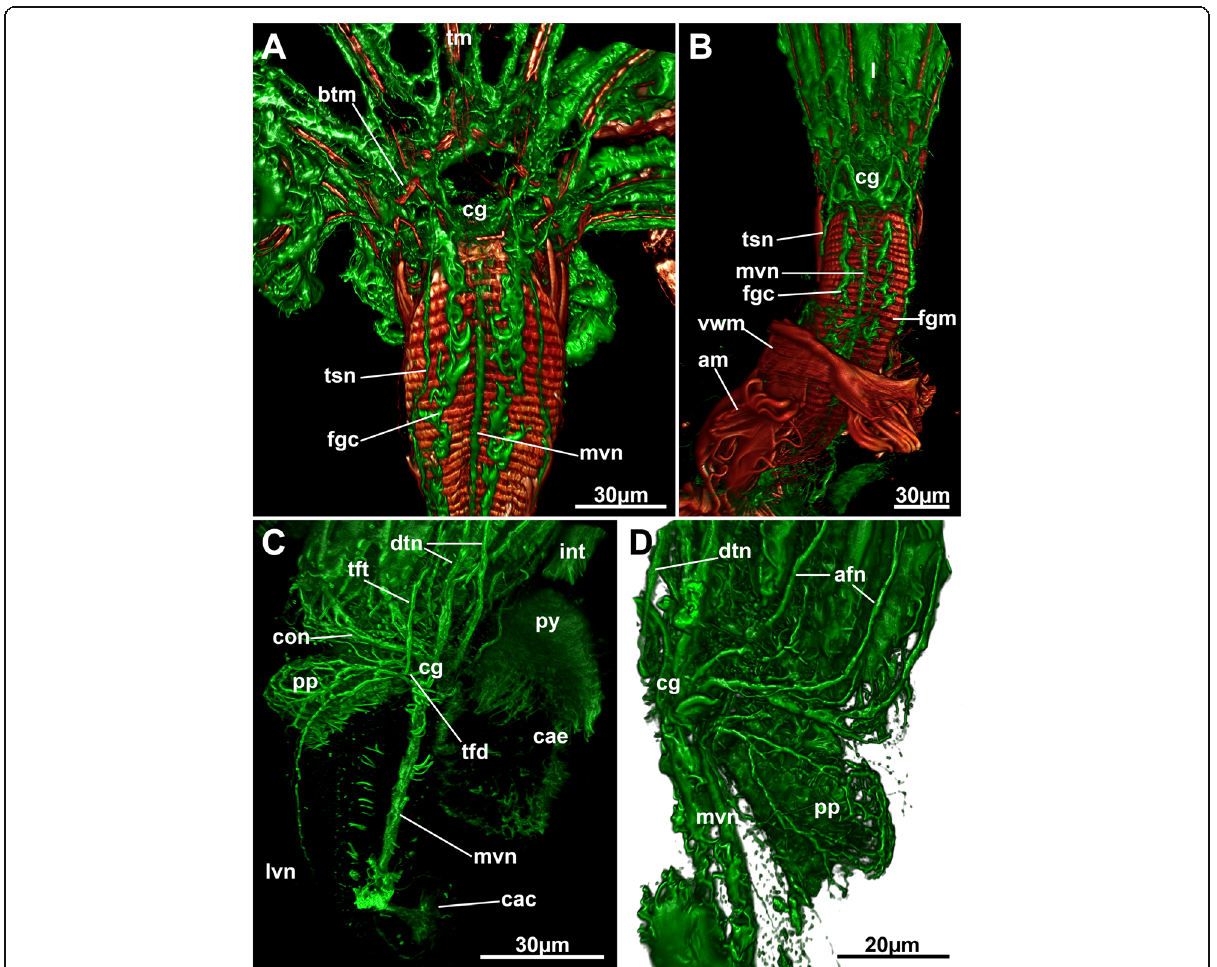
Fig. 5 Overview of the cerebral ganglion and main neurite bundles of Hypophorella expansa . Acetylated alpha tubulin staining (green), f-actin (glow), CSLM, volume rendering. a View from the anal side of an extended polypide showing the ganglion and visceral and tentacle sheath neurite bundles. Note also the ciliary streets on each side of the medio-visceral neurite bundle. b Similar to A, but showing the extension of the polypide from the apertural area. c Oblique view of the lophophoral base showing main peripheral neurite bundles from the ganglion. d Oblique view of the lophophoral base showing the circum-pharyngeal plexus. Abbreviations: afn – abfrontal tentacle neurite bundle, am –